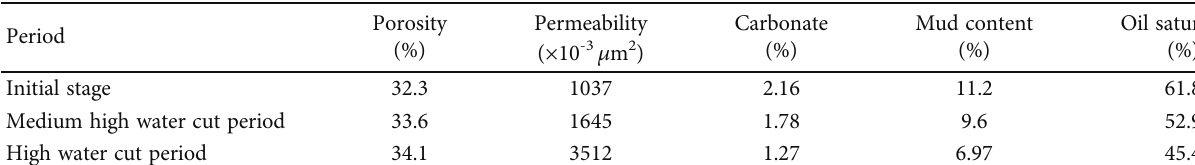
Table 2: Statistics of reservoir characteristics in di ff erent periods.